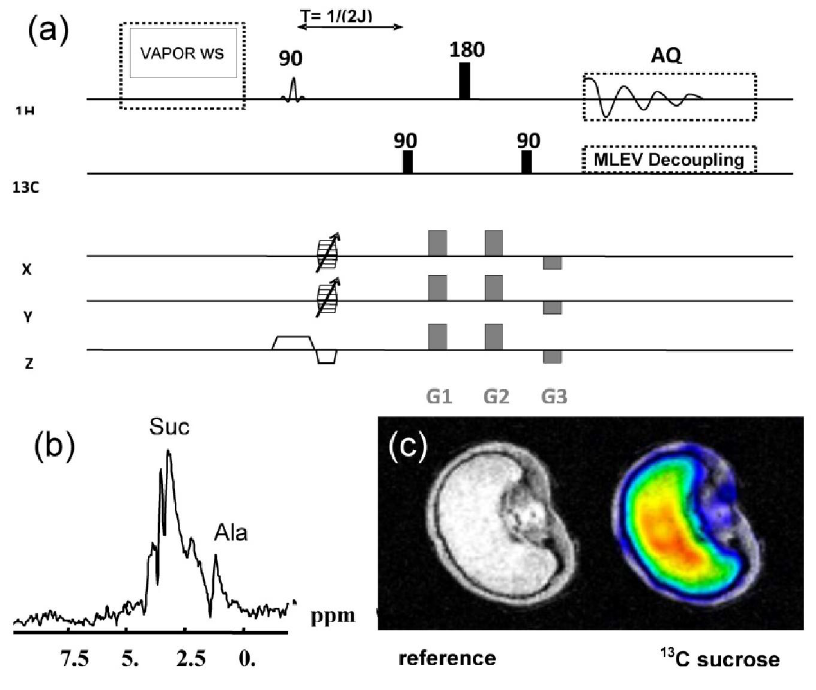
Figure 6. ge-HMQC spectroscopic imaging of a barley grain. ( a ) Pulse sequence with water pre-saturation and 13 C decoupling; ( b ) ge-HMQC spectrum from the endosperm region; ( c ) reference and metabolic images from 13 C sucrose after 14h feeding with 13 C labelled